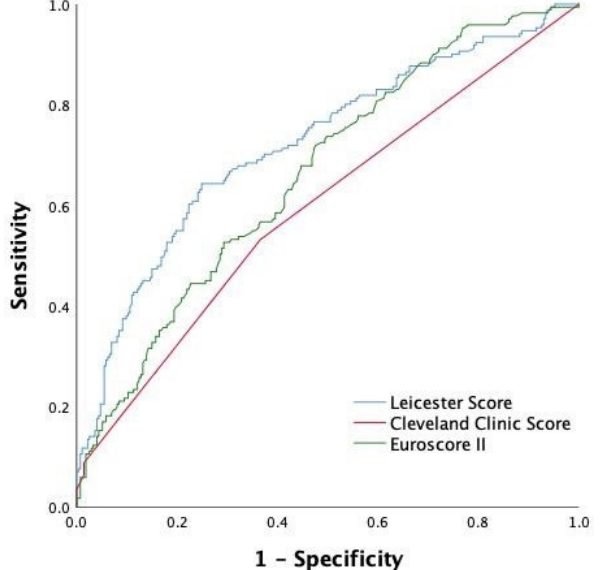
Figure 1. Receiver operating characteristic curve of each scoring system (Leicester score, Cleveland Clinic score, and Euroscore